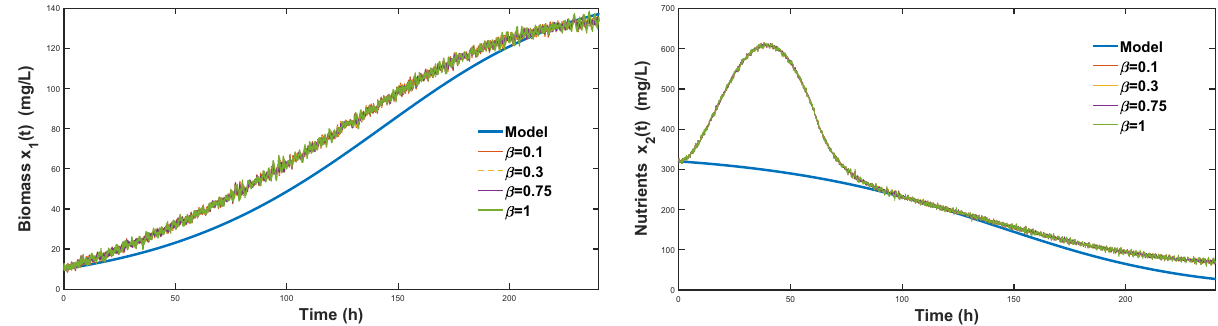
Figure 6: Comparison of the biomass dynamics in the presence of the four di ff erent controllers with a change of the beta.